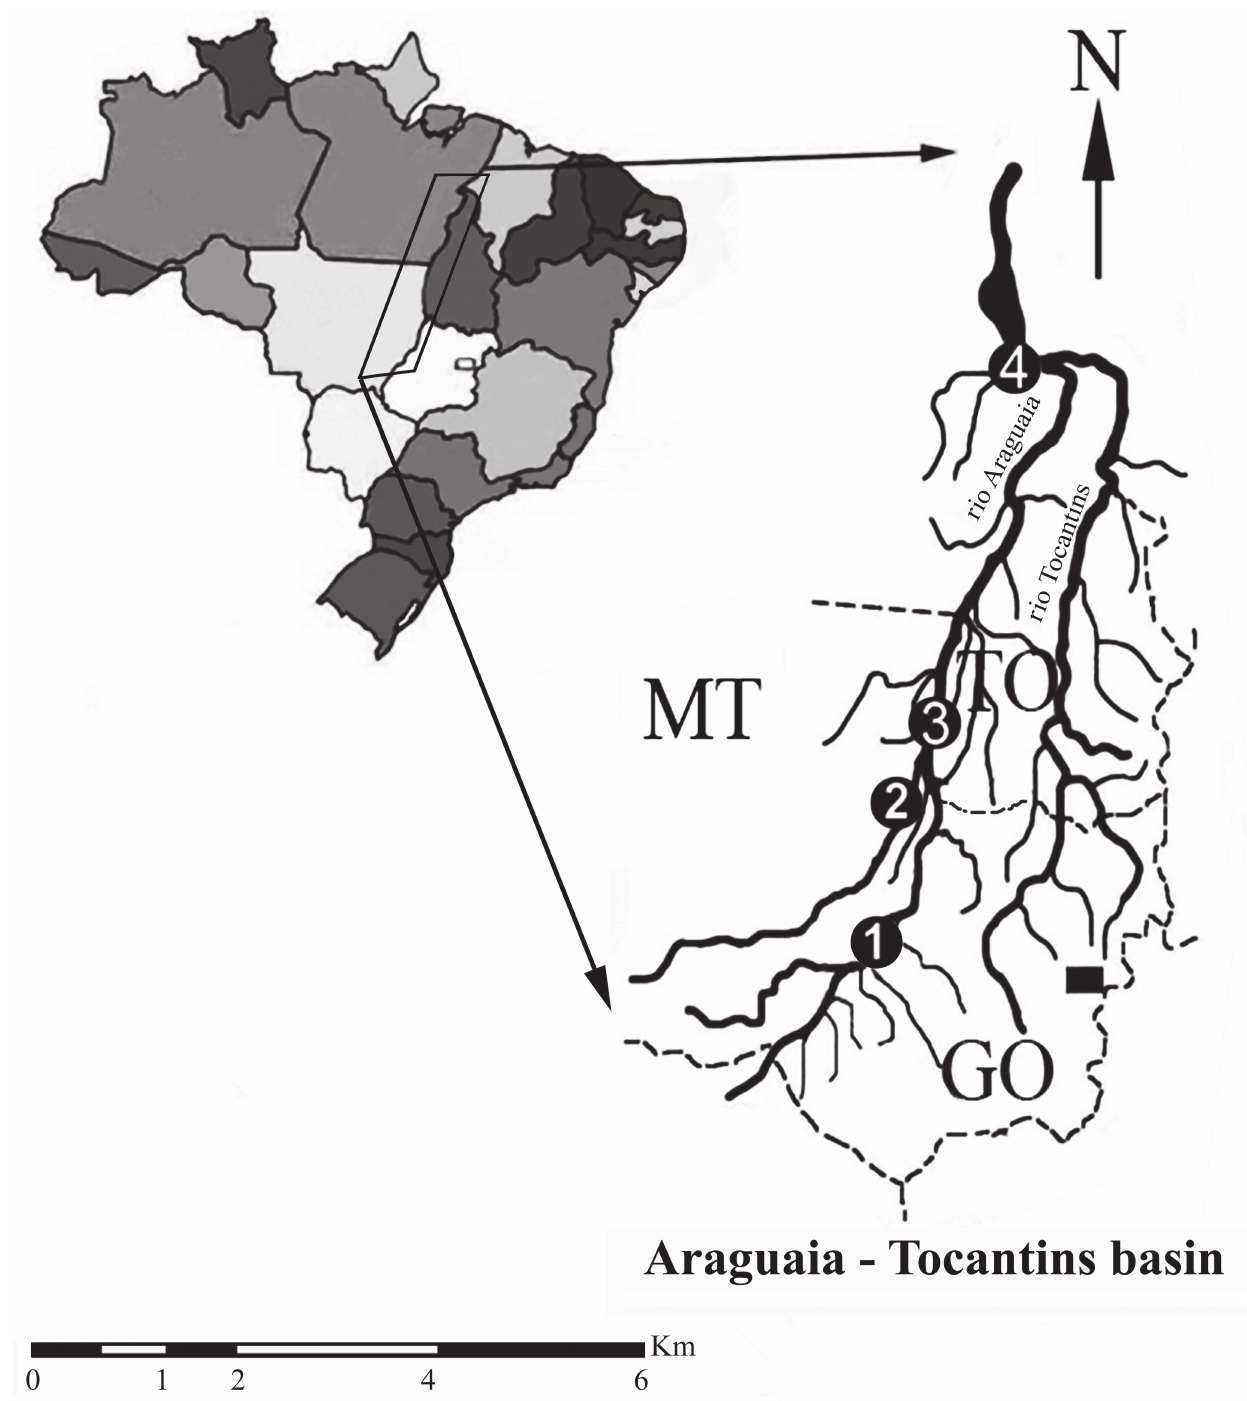
Fig. 1. Map of Brazil, with emphasis on the Araguaia-Tocantins basin. Collection sites of Arapaima gigas : (1) Araguaiana- MT, (2) Novo Santo Antônio-MT, (3) São Félix do Araguaia-MT, and (4)